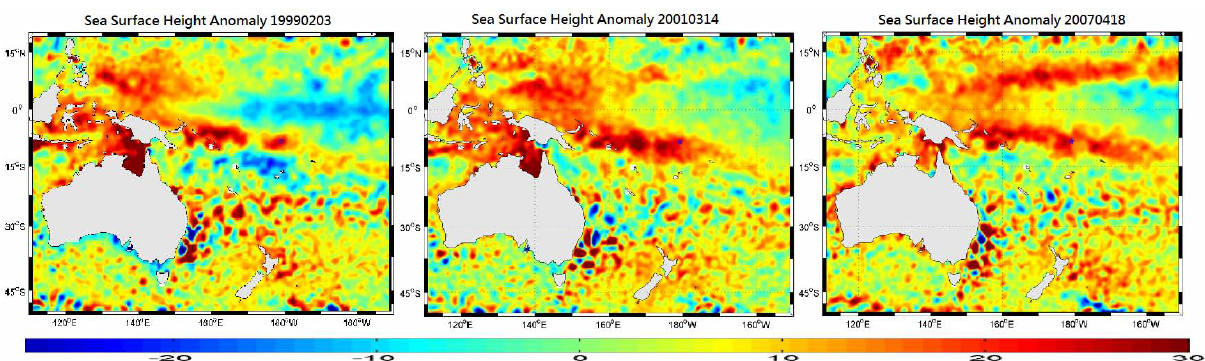
Fig. 7. The example images of sea surface height anomaly affected by warm water during non-highest astronomical tide period, and caused sea-surface rise of 21, 25, and 23cm, respectively.